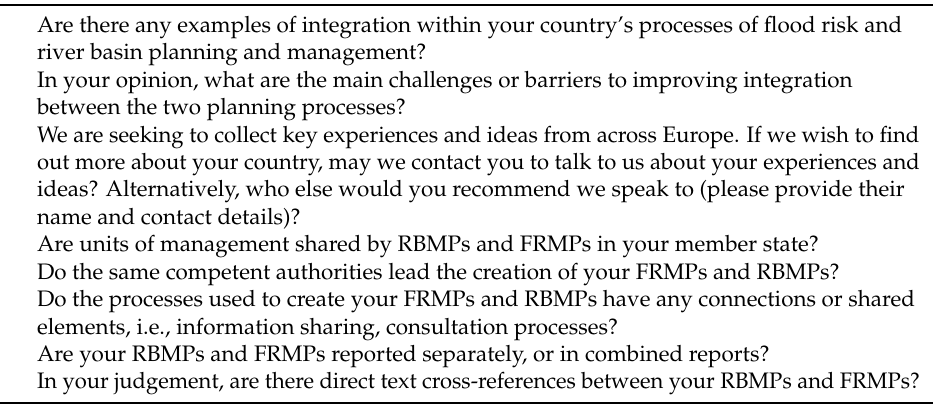
Table A2. Questions asked by email and in person to members of European Commission “Working Group